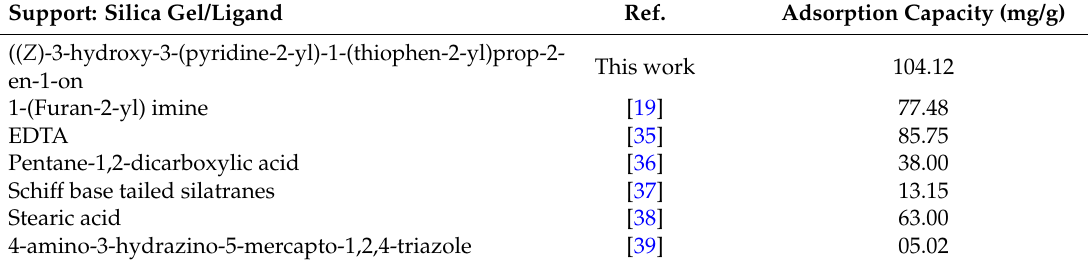
Cu 2+ adsorption performances of SiNTh-Py compared with that of some recently reported